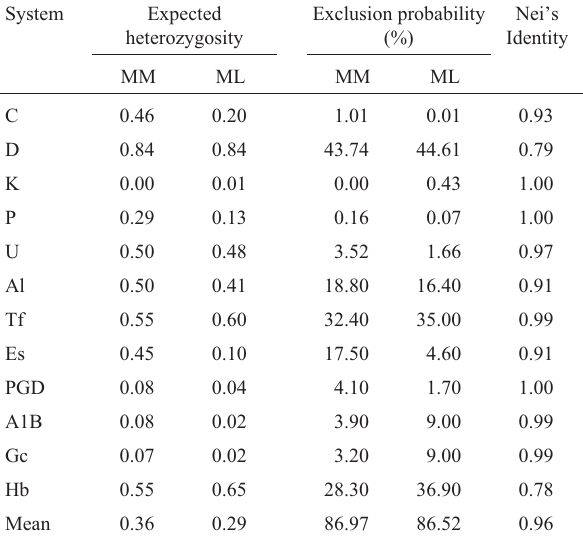
Table 2 - Blood factor frequencies of systems A, Q, and T in Mangalarga Marchador (MM) and Mangalarga (ML) breeds. Factors Aa